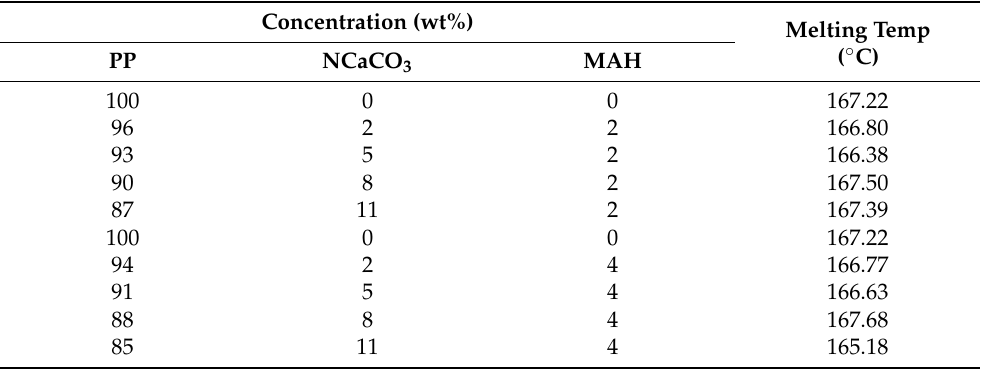
Figure 3. NMR analysis for PP nanocomposites with nano-CaCO 3 2% and 5% wt.